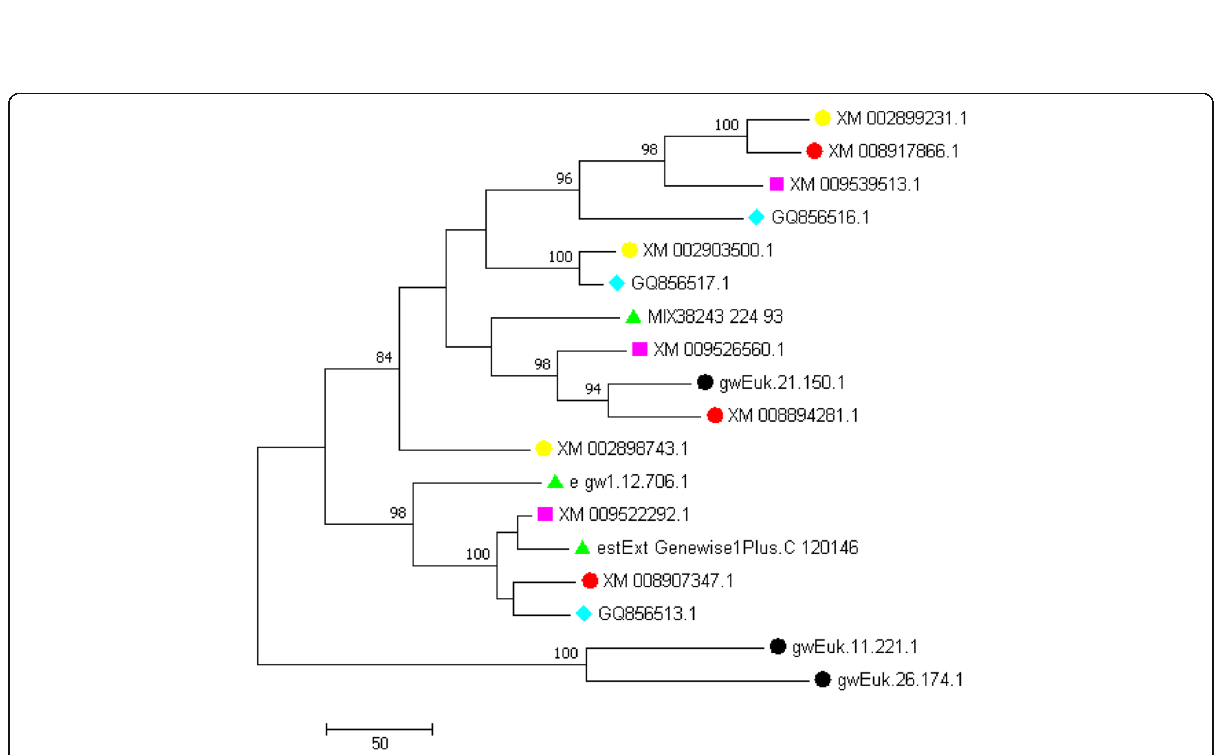
Fig. 3 Maximum Parsimony analysis of PL3-coding gene sequences from multiple Phytophthora spp. The evolutionary history of 18 Phytophthora spp. PL3-coding gene sequences was inferred using the Maximum Parsimony method and the consensus tree inferred from two most parsimonious trees is shown. The percentage (cut-off value=80%) of replicate trees in which the associated taxa clustered together in the bootstrap test (1000 replicates) is shown next to the branches. There was a total of 656 positions in the final dataset and all positions containing gaps and missing data were eliminated. The scale bar represents the number of nucleotide changes over the whole sequence. Taxa included in this analysis are P. sojae (magenta square), P. infestans (yellow circle), P. ramorum (black circle), P. capsici (cyan diamond), P. cinnamomi (green triangle), and P. parasitica (red circle). No NCBI accession identifiers are available for P. ramorum or P. cinnamomi ; therefore, identifiers from each genome project, as shown in FungiDB, were used instead. Tree shown is representative of the topology generated by the Neighbor Joining and Maximum Likelihood methods using the same dataset. Evolutionary analyses were conducted in